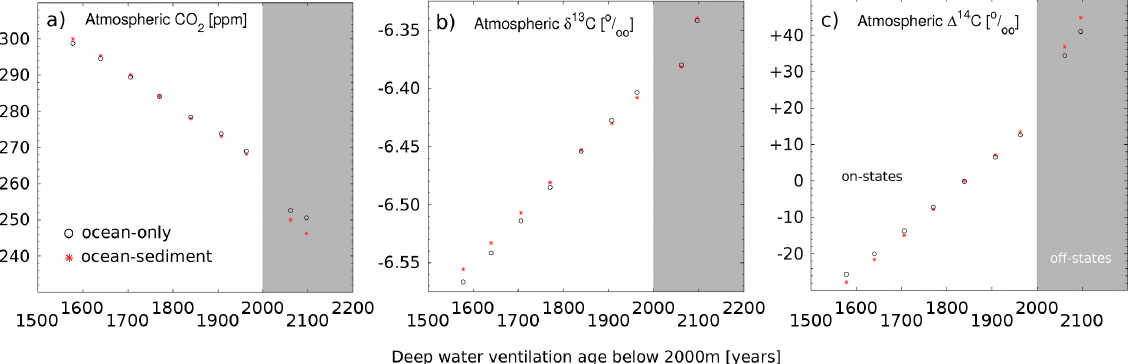
Fig. 7. Response in atmospheric (a) CO 2 , (b) δ 13 C CO , and (c) 1 14 C CO to changes in ocean ventilation. Displayed values are diagnosed 2 2 for the time slice at 2kyr after the perturbation in SO wind forcing. At this time carbon, cycling has reached a new equilibrium in the ocean-only model (circles), whereas the ocean-sediment model (stars) is still under relaxation at 2kyr due to the millennial-scale response of ocean-sediment